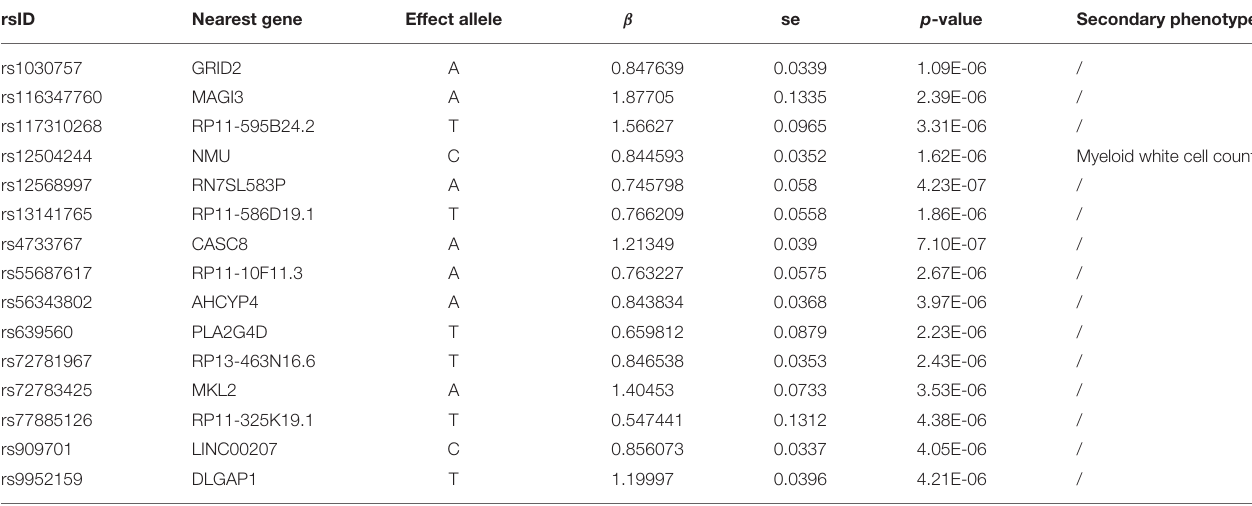
TABLE 4 | The 15 single-nucleotide polymorphisms (SNPs) used as instrumental variables of obsessive compulsive disorder (OCD).